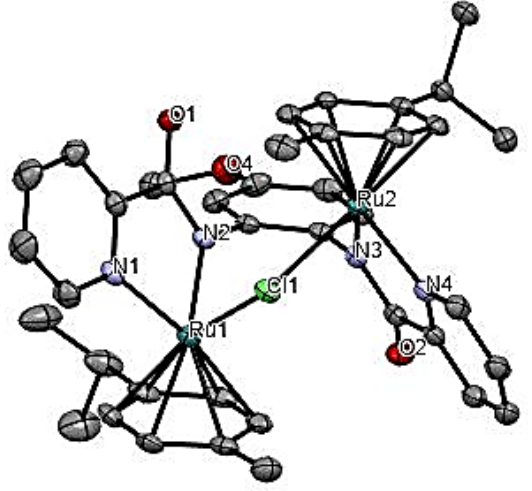
Figure 1. Molecular structure of Ru1, with ellipsoids drawn at 50% probability level. Hydrogen atoms, CH 2 Cl 2 solvent and [RuCl 3 (p-cymene)] - counter-anion have been omitted for clarity. Selected bond lengths (Å ): N(1)-Ru(1), 2.104(4); N(2)-Ru(1), 2.094(4); Ru(1)-Cl(1), 2.4526(12); Ru(1)-Ru(2), 4.168(5). Selected bond angles (°): N(1)-Ru(1)-N(2), 77.55(15); N(1)-Ru(1)-Cl(1), 85.37(11); N(2)-Ru(1)-Cl(1), 86.96(11); Ru(1)-Cl(1)-Ru(2), 115.68(4).